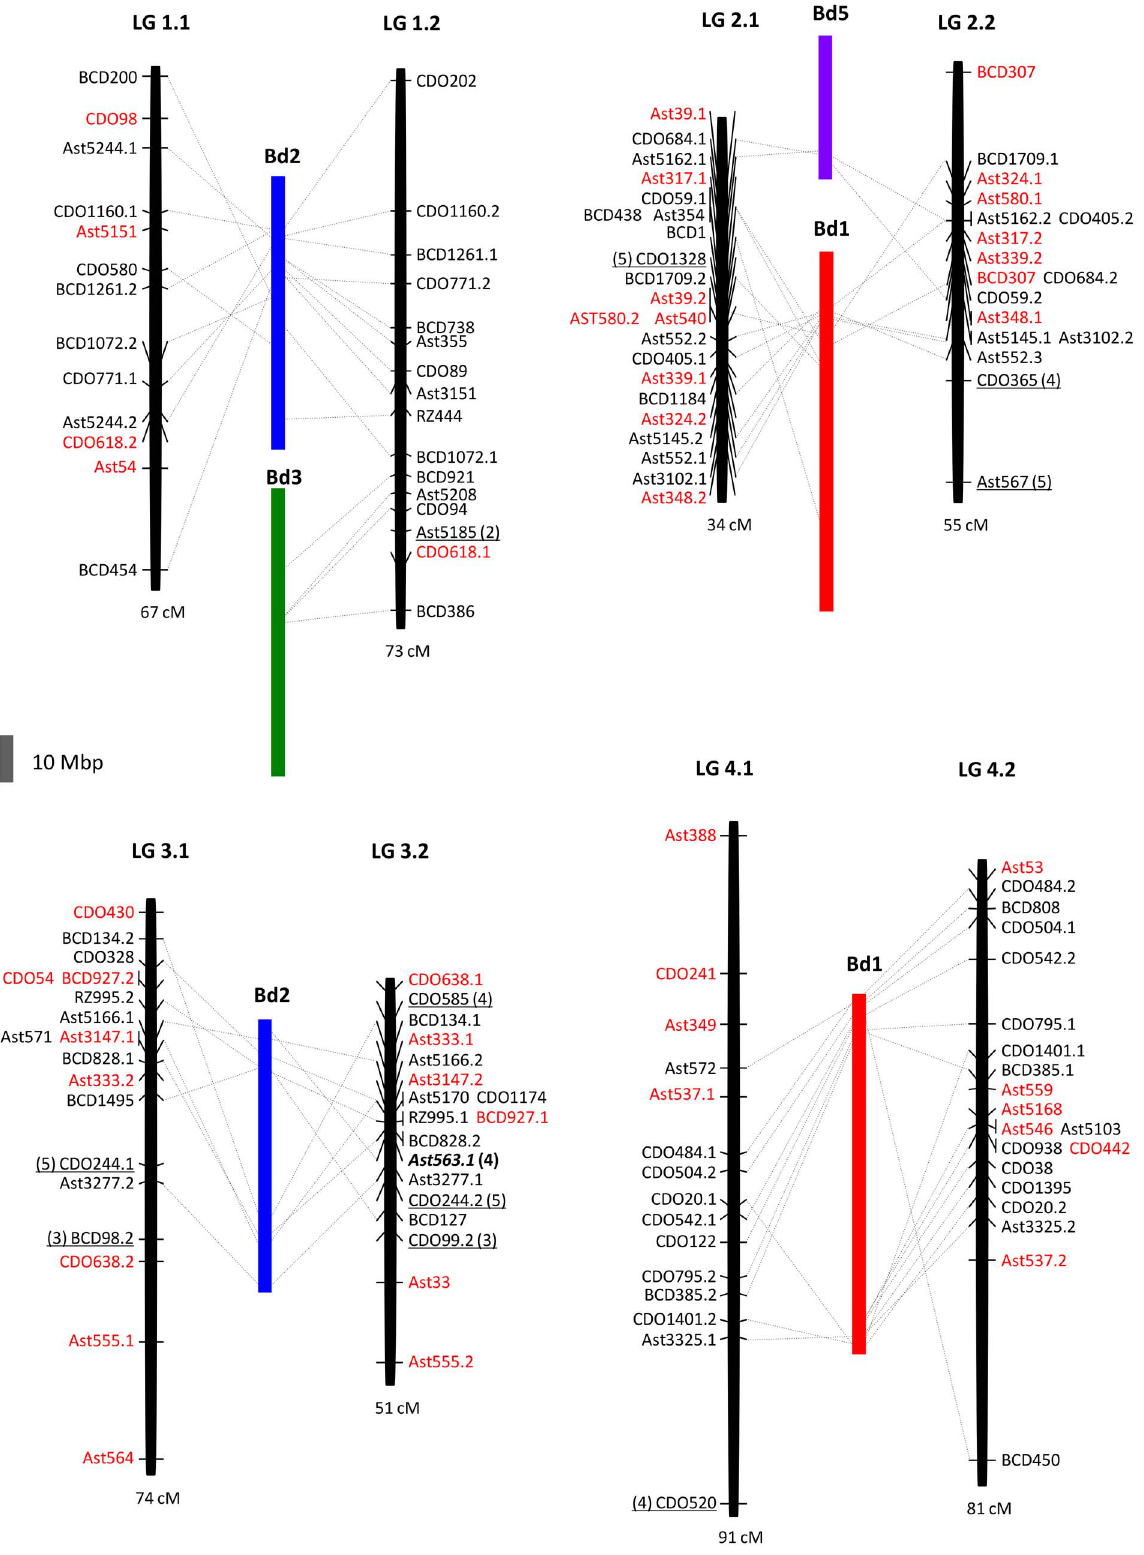
Figure 4. Comparative genome relationship on creeping bentgrass linkage groups 1 – 4 relative to Brachypodium distachyon . Comparative genome relationship between creeping bentgrass genetic linkage map and chromosomes of B. distachyon by determining the chromosomal location of sequences of the EST-RFLP markers mapped on the creeping bentgrass linkage map. The black bar represents each of the bentgrass linkage groups (total length in cM, below the bar) as shown in Figure 1. The colored bars represent each of B. distachyon chromosomes